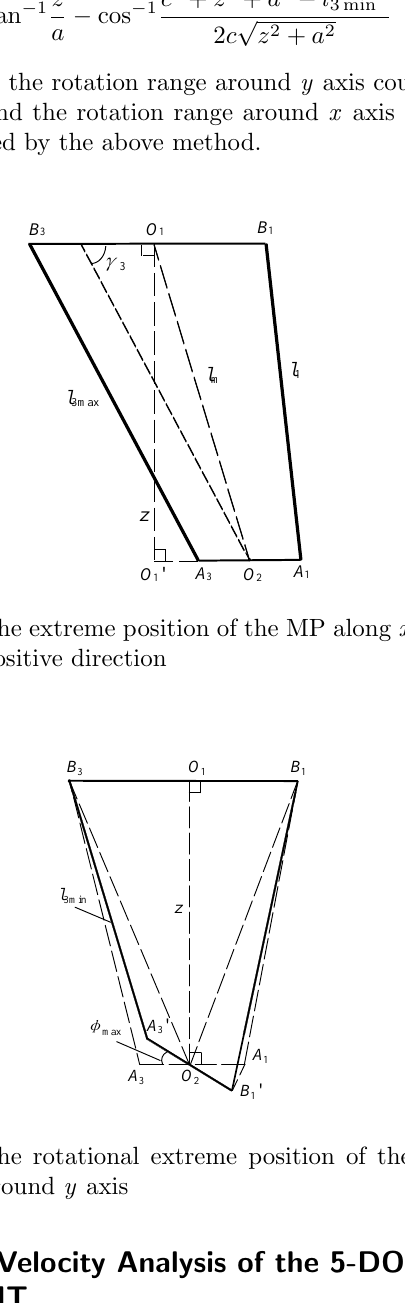
Table 1: The vectors used in Figure 6 ( 1,2,3,4 i  ) Parameters Meaning v The speed of the sliding platform sliding 1 O on the guide v The velocity of the MP 2 O ω The angular velocity vector of the MP v i